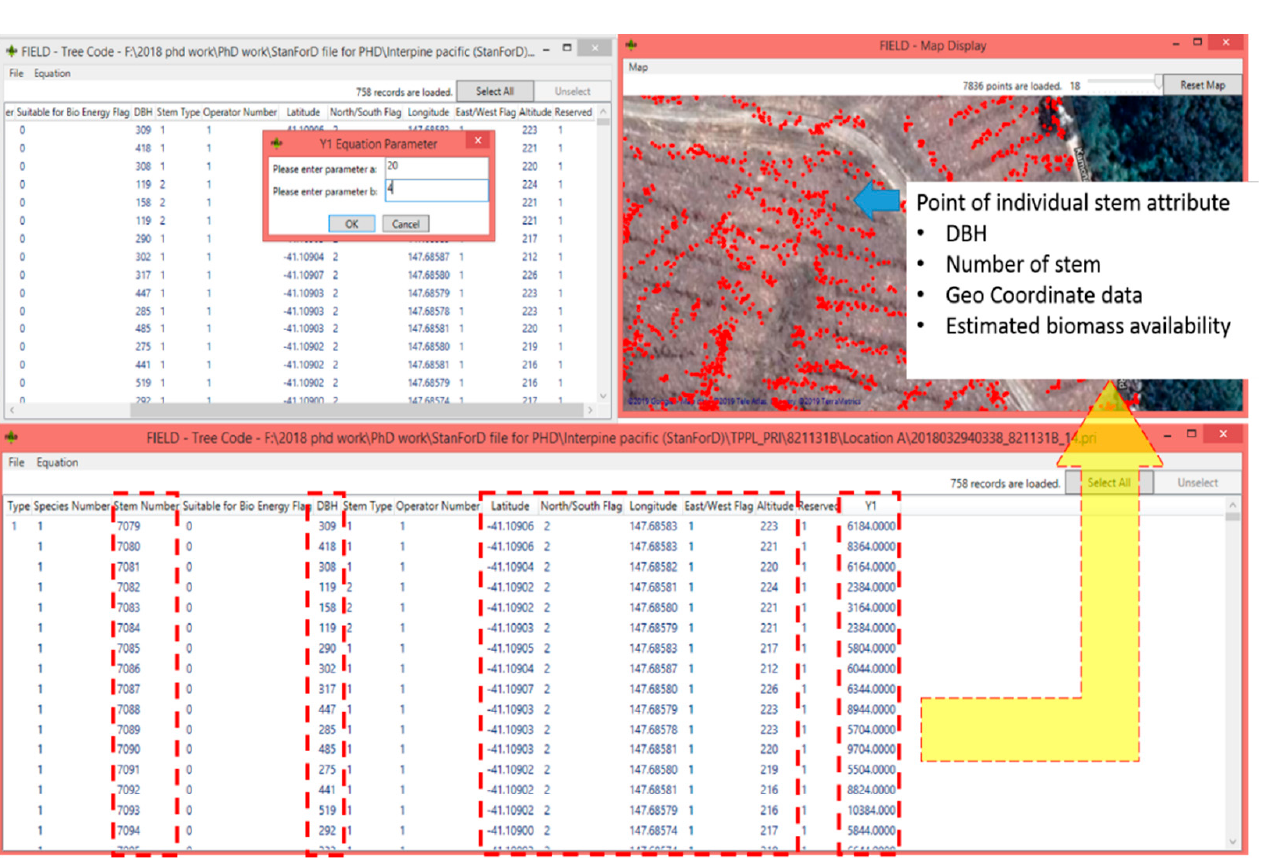
Figure 7. Real − time biomass monitoring system and biomass availability map developed by the FIELD tool.